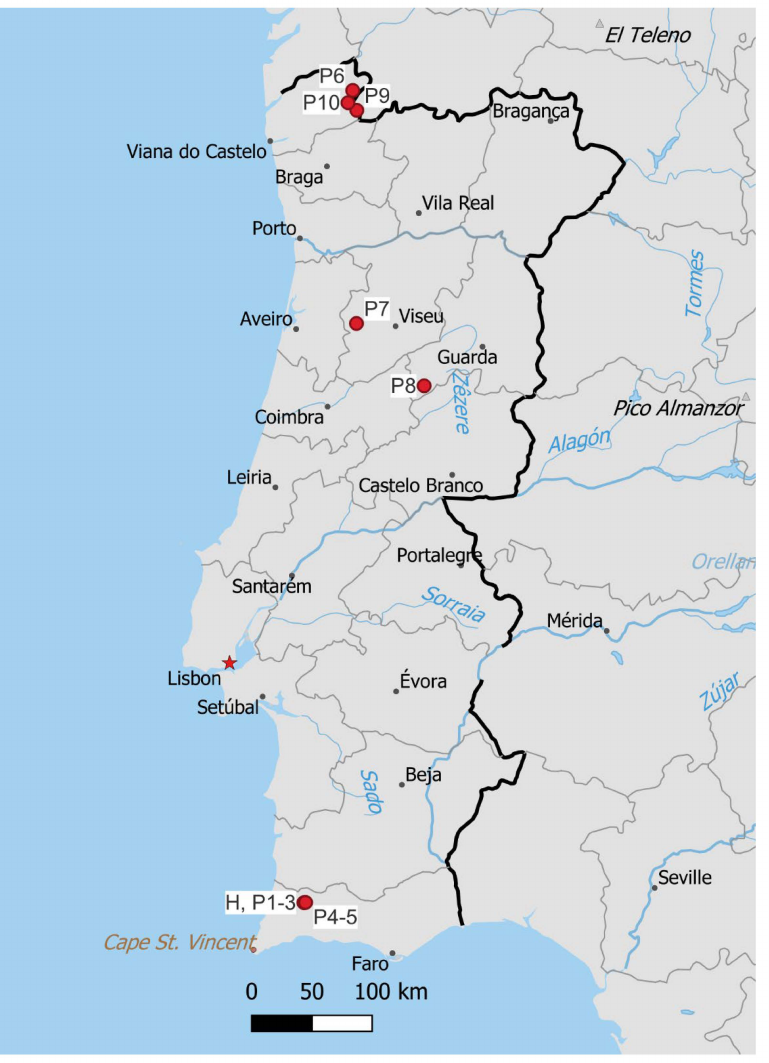
Figure 7. Known distribution of Marsupella lusitanica . H denotes the locality of holotype, P1–10 correspond to localities of paratypes 1–10. Made with Natural